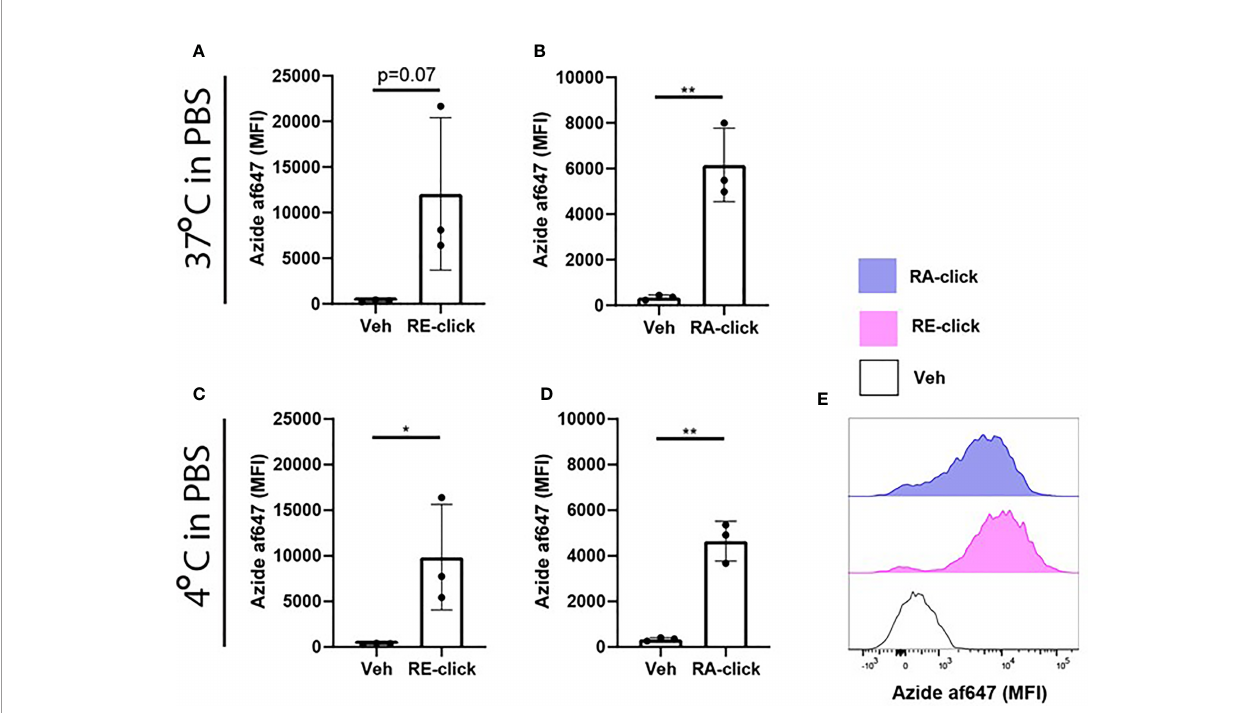
FIGURE 2 | Uptake of dickable retinoids in human dendritic cells is independent of protein and temperature. Monocytes were isolated from blood and differentiated into monocyte-derived dendritic cells (moDCs) during 7 days of culture in the presence of GM-CSF and IL-4 from 3 different donors. Uptake of (A) RE-click and (B) RA-dick compared to the vehicle control in differentiated moDCs after incubation in phosphate buffered saline (PBS) for one hour at 37°c was determined by fl owcytometric analysis and expressed as mean fl uorescent intensity (MFI). Uptake of (C) RE-click and (D) RA-click compared to the vehicle control in differentiated moDCs after incubated in phosphate buffered saline (PBS) for one hour at 4°C was determined by fl owcytometric analysis and expressed as MFI. (E) Representative histogram of uptake of RE- (pink) and RA-click (blue) compared to the vehicle control (solid line) in moDCs at 4°C, as shown in (C, D) Data are presented as mean± SD. Student's t test; *p < 0.05, **p <